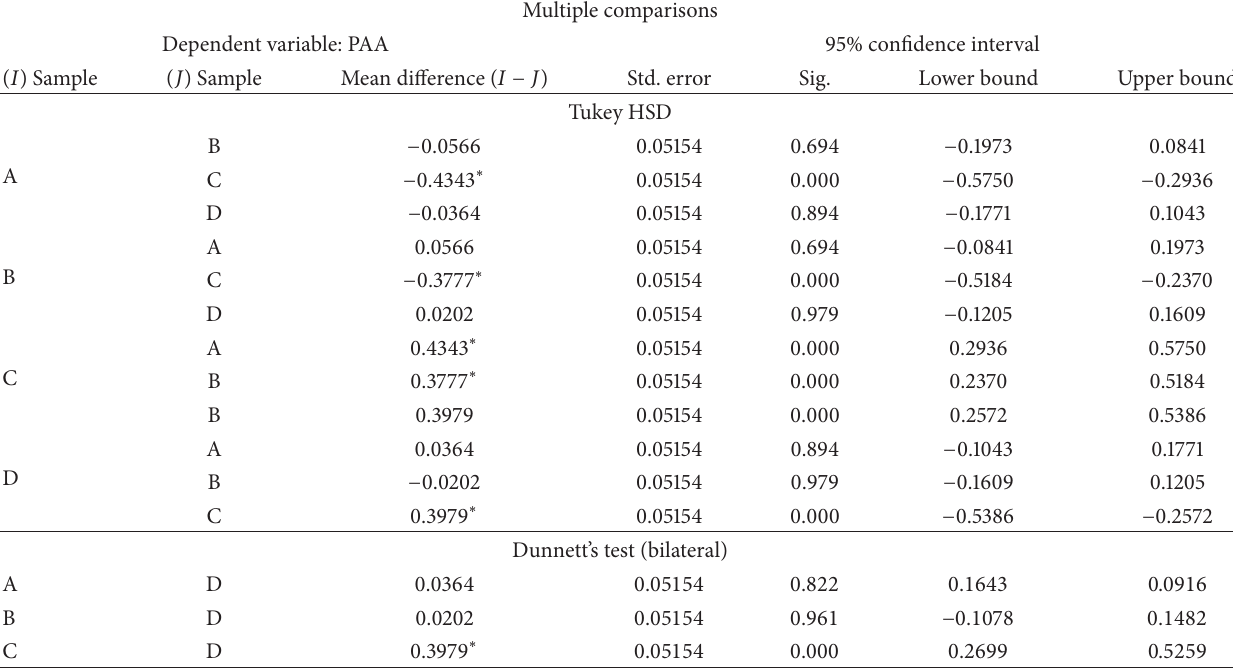
Table 5: Post hoc proof on multiple comparisons for peroxyacetic acid (PAA) taking into account the sample as independent factor.